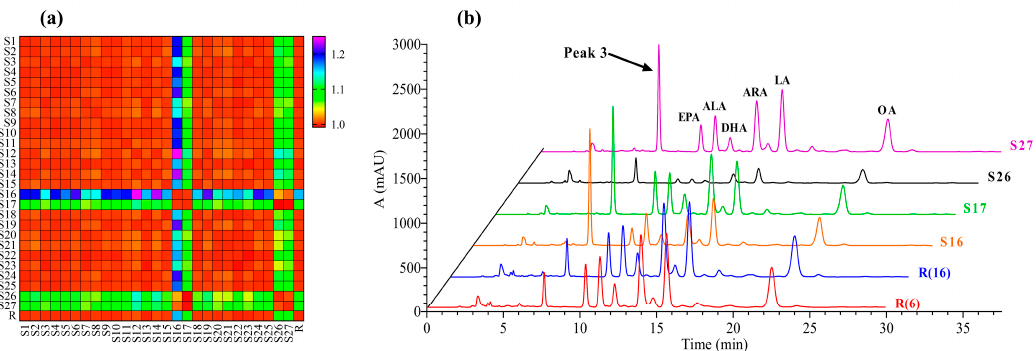
Figure 6. The heat maps of fingerprint similarity data matrices. ( a ) The heat map of method one and ( b ) The heat map of method two.